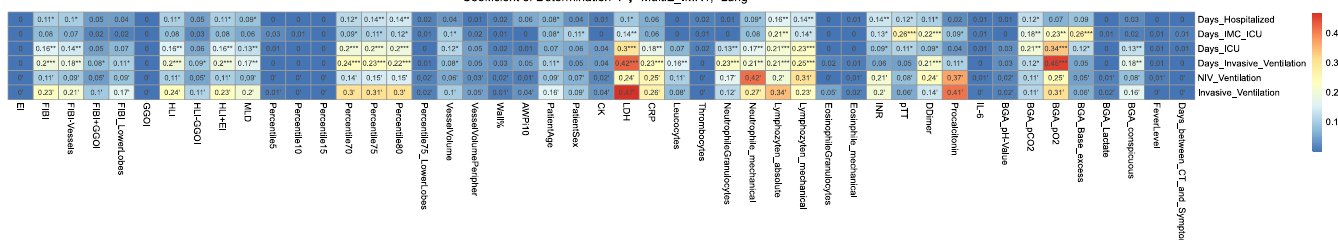
Fig 4. Heat map of coefficient of determination r 2 for the correlation of outcome parameters with laboratory and QCT parameters. For binary outcome parameters (NIV_Ventilation and Invasive_Ventilation) the Mc Fadden pseudo r 2 was calculated, there is no p-value to specify for this value. Signif. codes: ��� p < 0.001 / �� p < 0.01 / � p < 0.05 / ’ no p-value available.